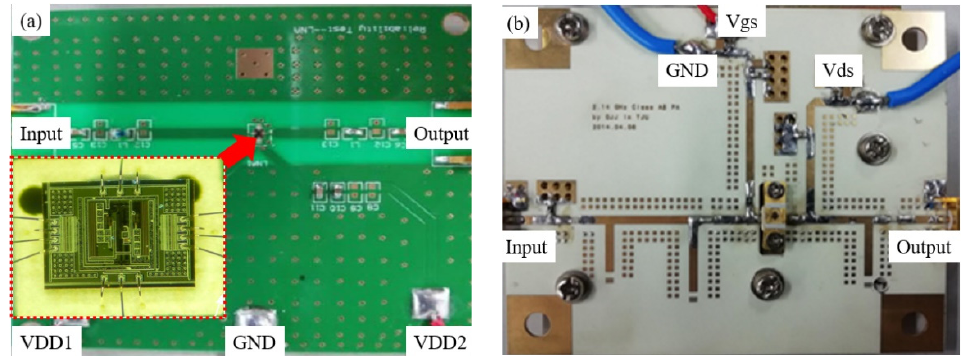
Figure 1. The photograph of the: ( a ) Complementary Metal Oxide Semiconductor low-noise amplifier (CMOS LNA); ( b ) Gallium Nitride class-AB power amplifier (GaN Class-AB PA).